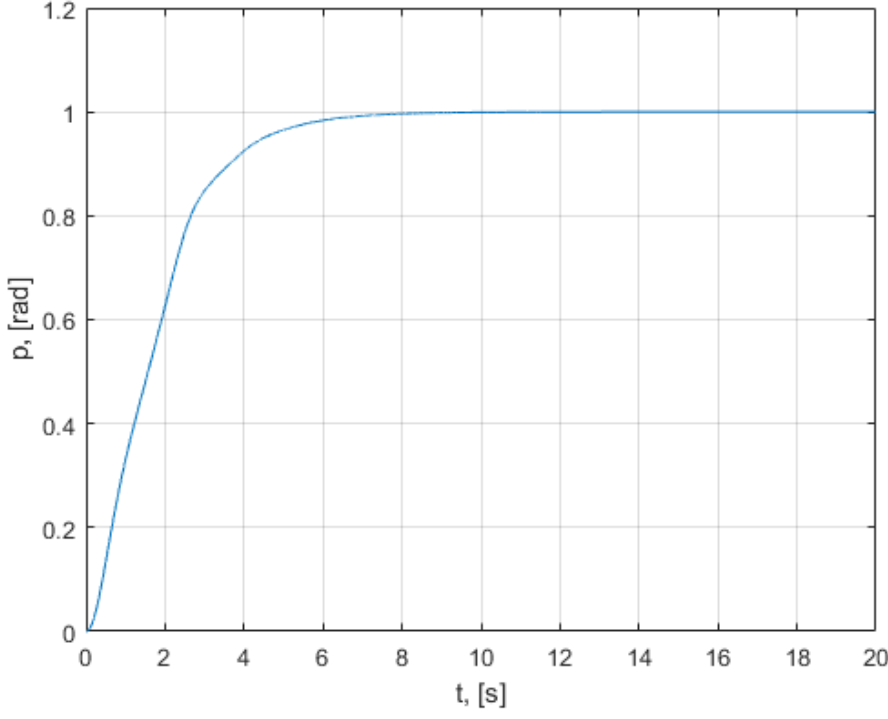
Figure A8. The speed response of position control system.